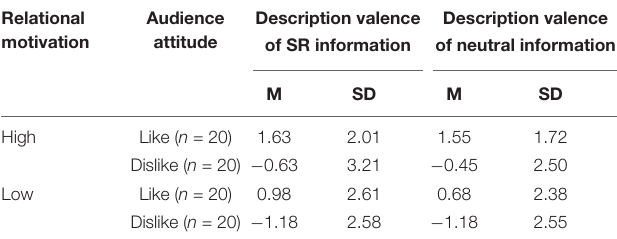
TABLE 2 | Description valence as a function of relational motivation and audience attitude.